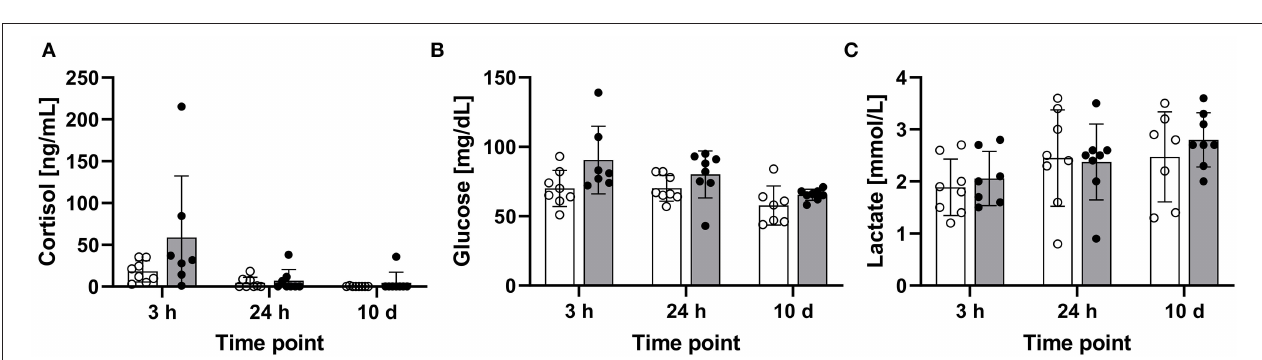
FIGURE 3 | Concentrations of blood parameters in the treated and control maraena whitefish. The concentrations of (A) plasma cortisol (ng/mL), (B) glucose (mg/dL), and (C) lactate (mmol/L) in eight individuals per time point are illustrated as box and whisker plots. Bars represent the mean values in control (white) and treated (gray) fish. Individual measurement points are indicated by blank (control) and filled (treatment) dots; error bars indicate standard deviation.